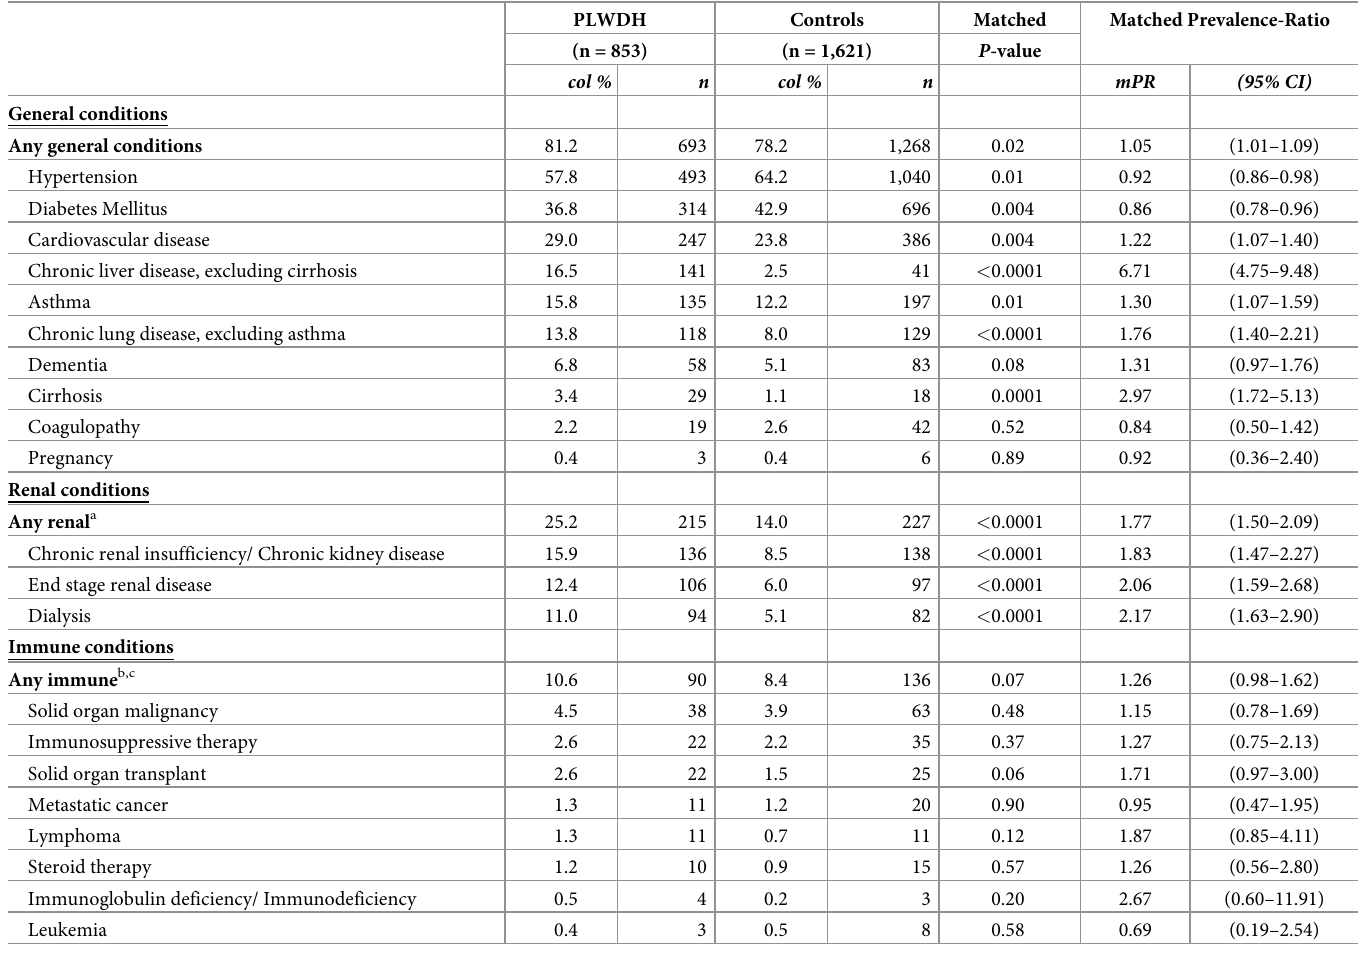
Table 2. Comorbidities noted at admission among PLWDH and matched